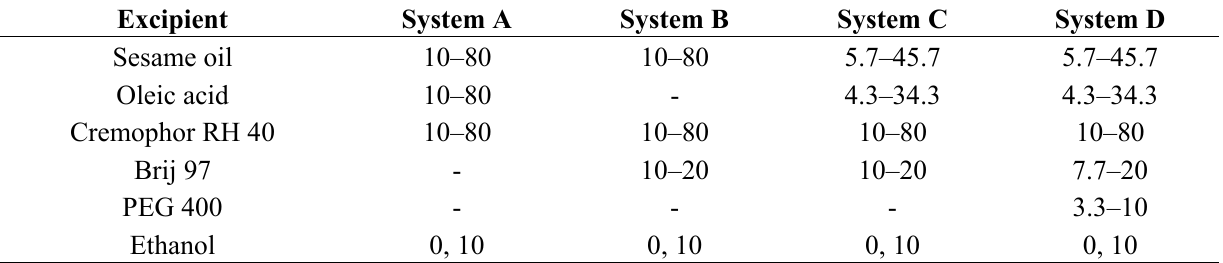
Table 2. The ratios of different excipients examined in the present study (% w / w ).